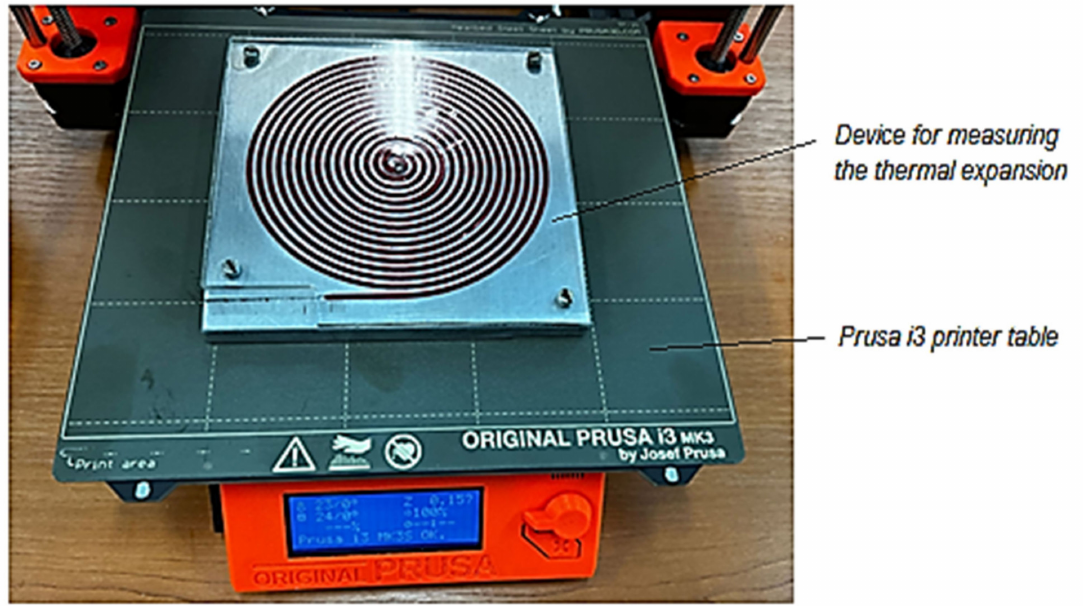
Figure 5. Image of a device for measuring the expansion or thermal shrinkage of a polymer spiral test sample together with the aluminum alloy plate placed on the printer’s table to reach the temperature at which the spiral test sample begins to cool and